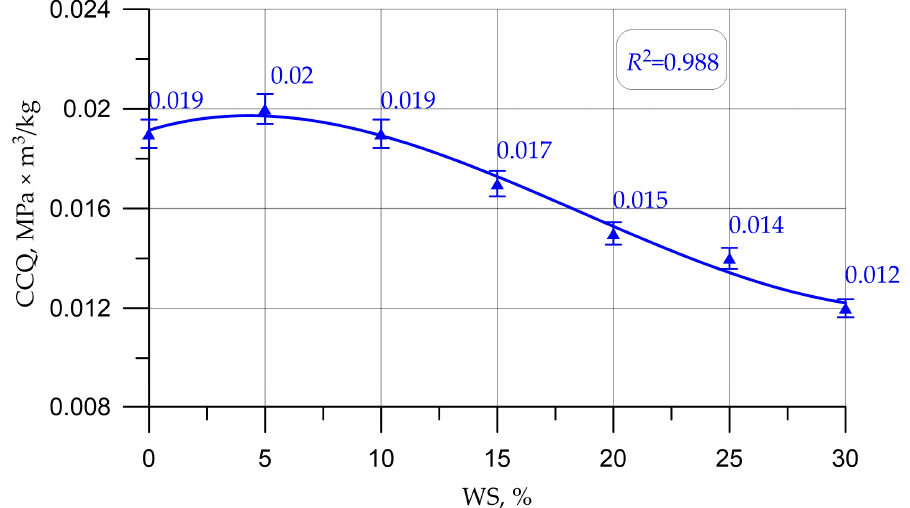
Figure 10. Change in the CCQ of concrete depending on the walnut-shell content. The best value for the CCQ is for concrete with a walnut-shell content of 5%, and the CCQ values for concrete with the control composition and with 10% walnut-shell content are approximately equivalent. The dependence of CCQ on the WS content is well approximated by a polynomial of the third degree, and is shown in Equation (7) with a